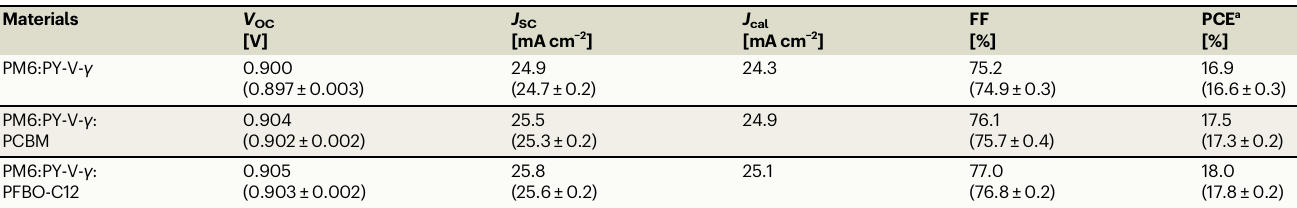
a Averagevalues from 16 individual devices withthe averagevalues shown in